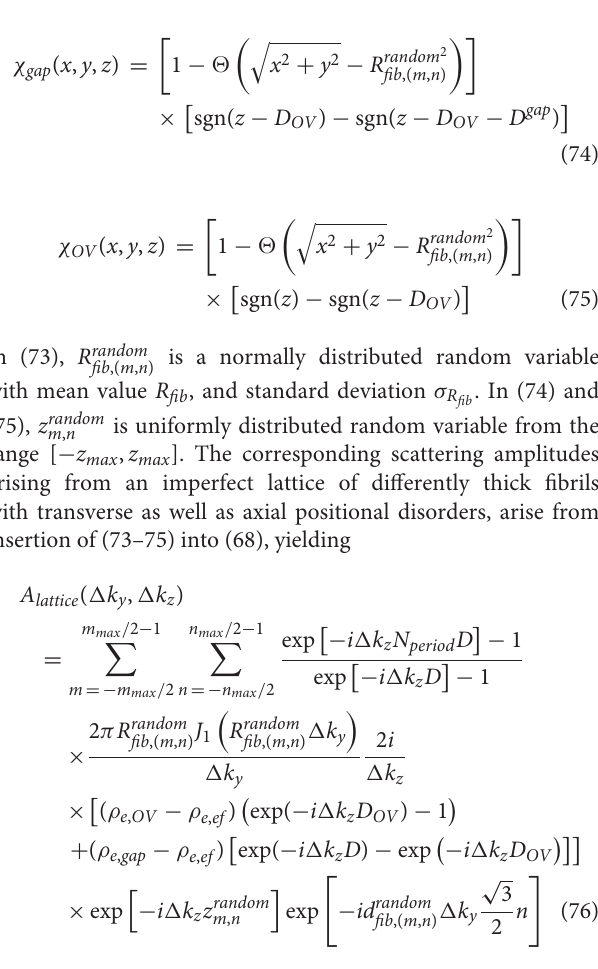
60 ◦ , see = a , σ a and ⊥ b , σ b , σ b , ⊥ ⊥